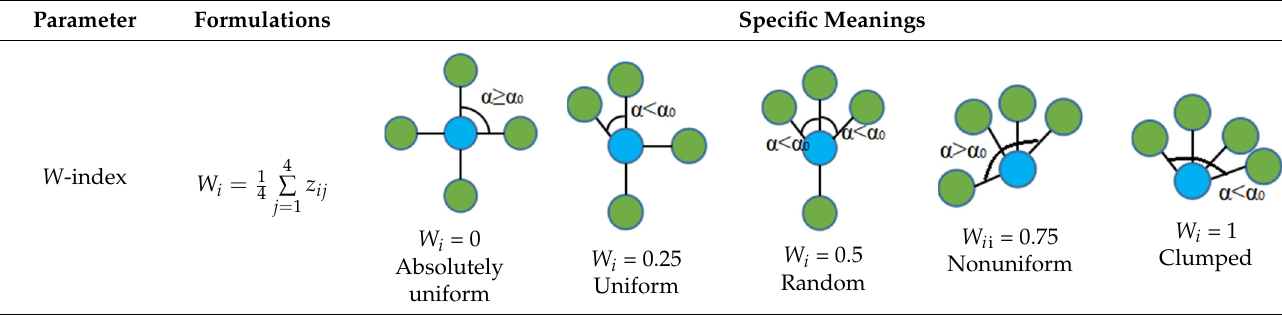
Table 2. Forest spatial structure indices with explanations.